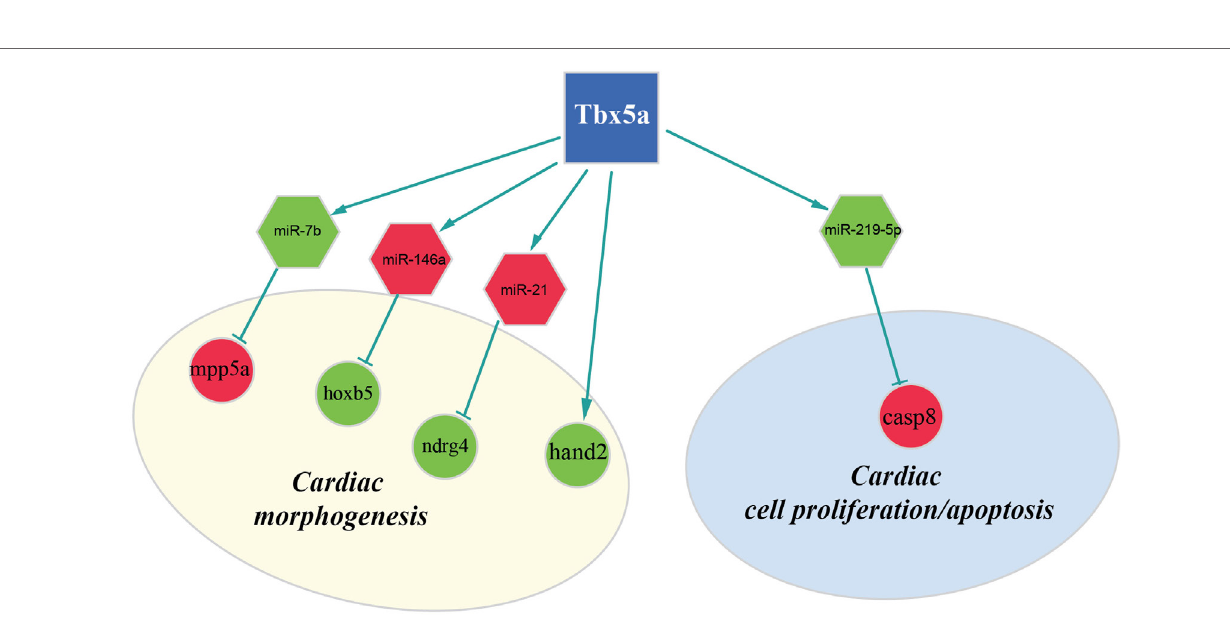
FigUre 4 | regulatory network altered in zebrafish hOs model at 48 hpf . Potential interactions involving Tbx5, miRNAs, and their targets are shown together with the functional impact in heart development.